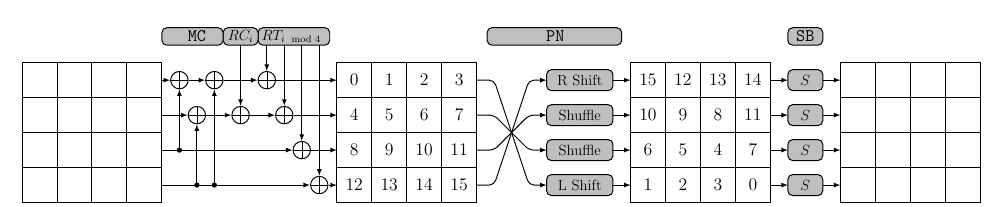
Figure 1: One full round of CRAFT